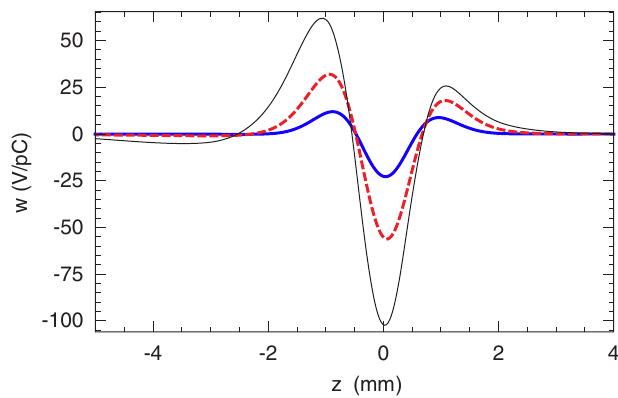
FIG. 9. (Color) Wakefields for the case A ¼ 3 and b ¼ 2 cm after the beam exits from the toroidal section at various distances (cid:2) s from the exit: blue line— (cid:2) s ¼ 0 ; red broken line— (cid:2) s ¼ 2 m ; and thin black line— (cid:2) s ¼ 4 m .